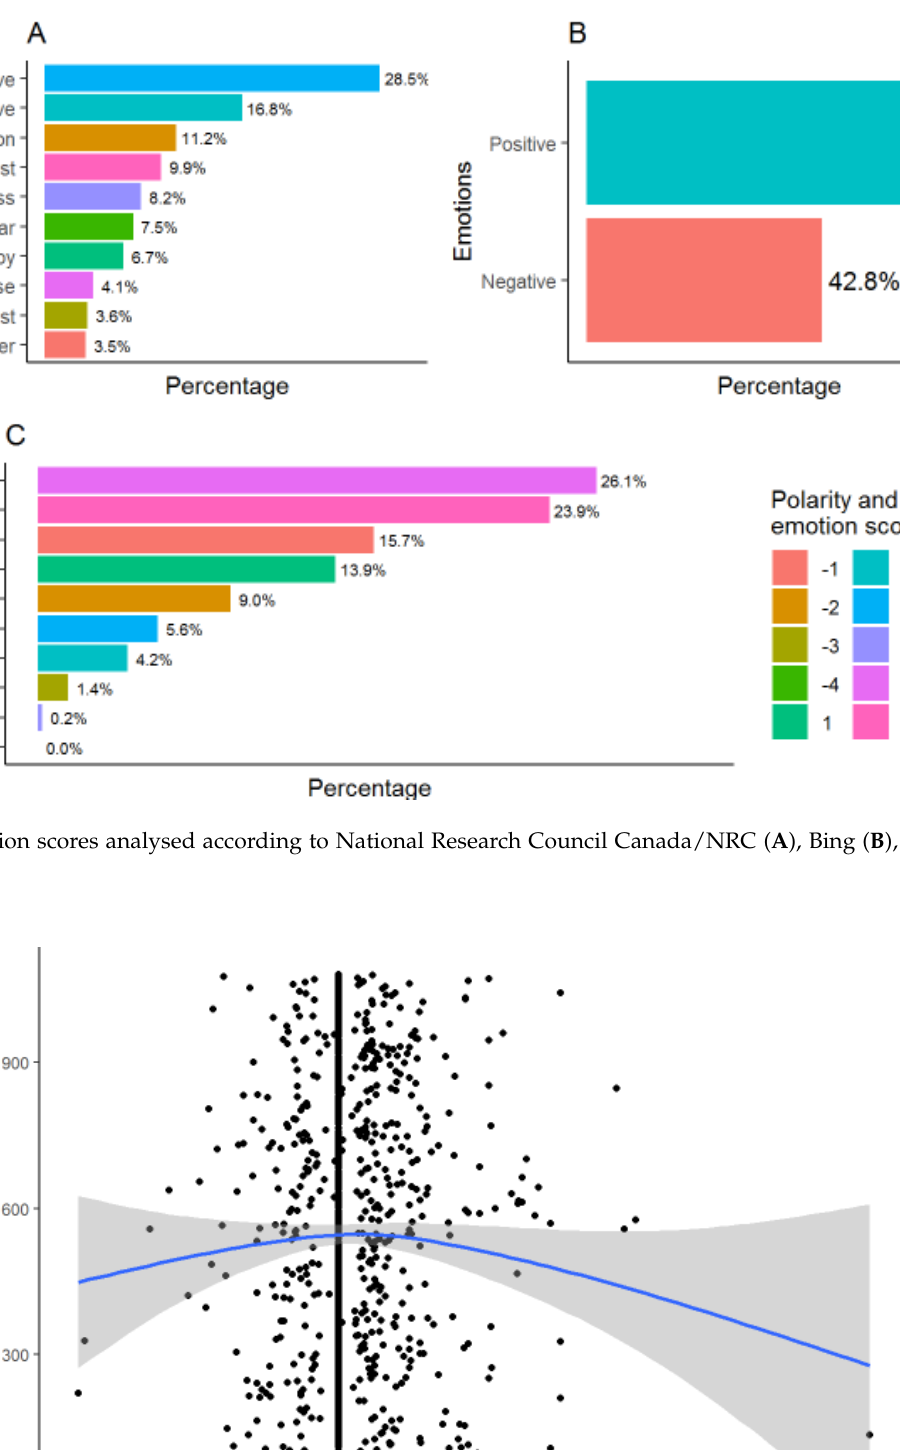
Figure 4. Polarity scores.